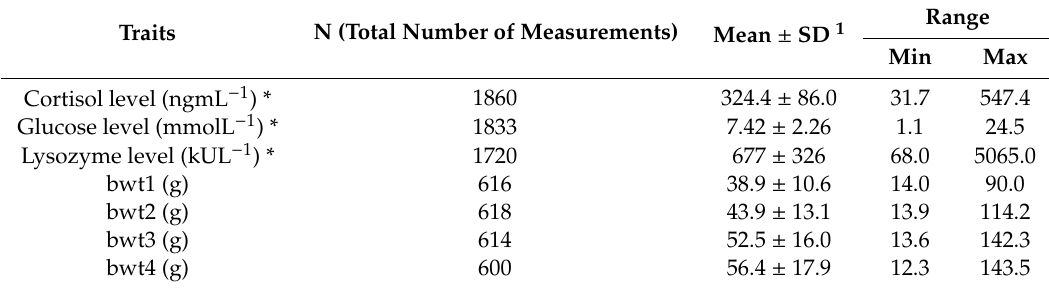
Table 1. Total number of measurements, mean, standard deviation, and range of values per trait.